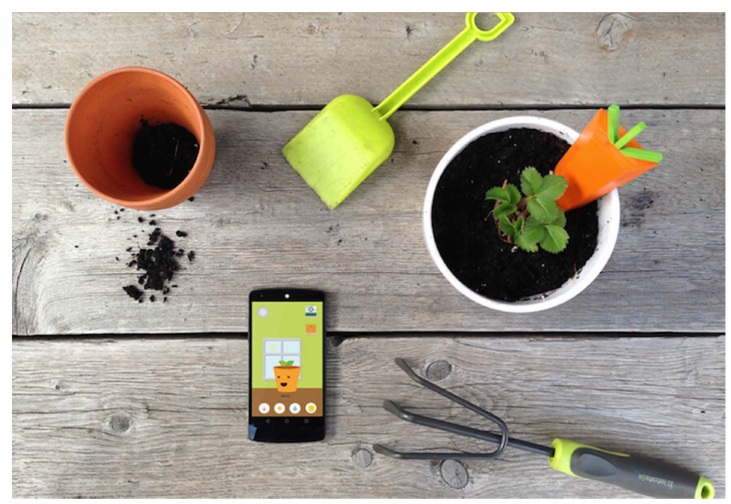
Figure 7. The sensor mockup and the